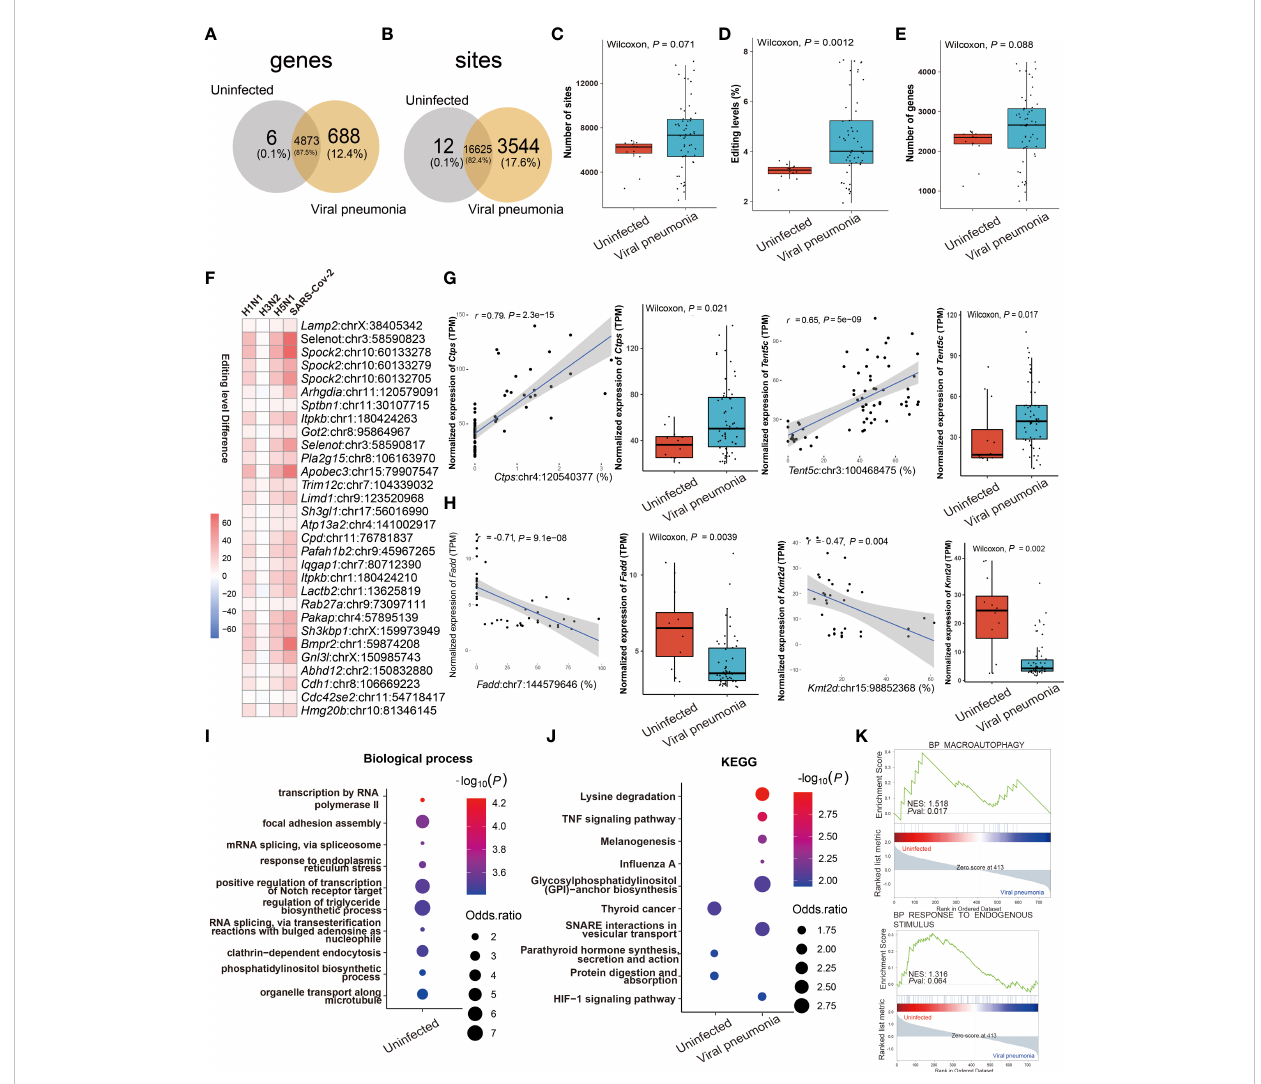
FIGURE 4 RNA editing pro fi les of ssRNA viral pneumonia. (A) Venn plot comparing the A-to-I editing sites detected in two or more samples among the groups. (B) Comparison of A-to-I RNA editing sites between the groups. (C) The number and (D) editing level of A-to-I RNA editing sites, and (E) the number of A-to-I RNA editing genes. (F) Top 30 DRE sites that shared by all ssRNA viral pneumonia. Each square represents the difference in the editing level of the edited site between uninfected and infected groups. (G, H) Spearman correlation between the gene expression and editing level of Ctps, Tent5c , Fadd , and Kmt2d . The most signi fi cantly enriched items of (I) biological processes and (J) KEGG pathway are shown. Selected GSEAs of DRE genes are listed in (K)